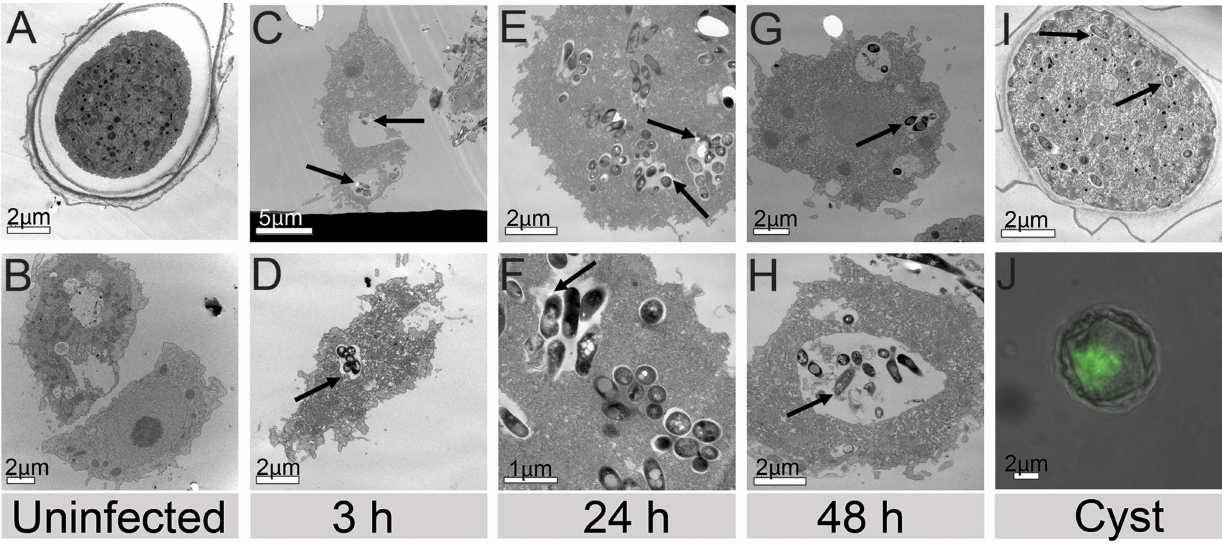
Figure 4. Transmission electron microscopy showing uninfected (A) cysts and (B) trophozoites as well as the intravacuolar location of M.ulcerans (arrows) within infected, intact trophozoites (C, D) 3 h, (E, F) 24 h, (G, H) 48 h and (I) cysts 3 weeks post infection. ( J ) is a composite image showing a cyst 22 days post infection by fluorescence microscopy.